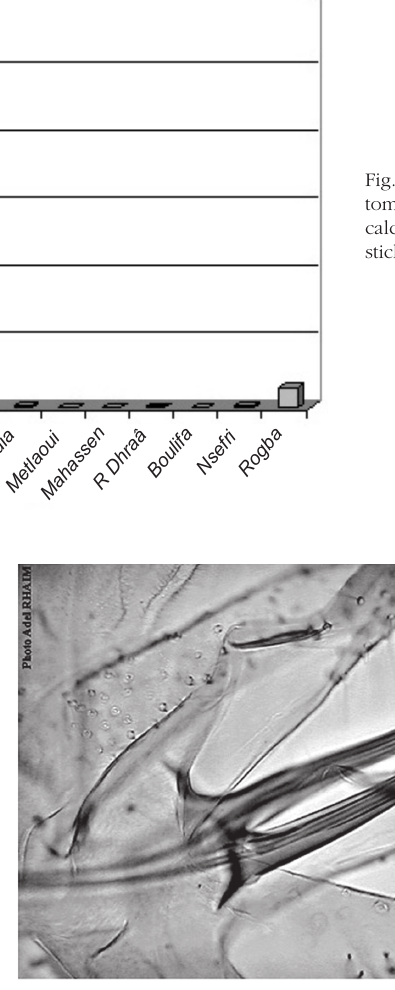
Fig. 3. – Density of phlebo- tomine sandflies per focus calculated on collections of sticky traps.